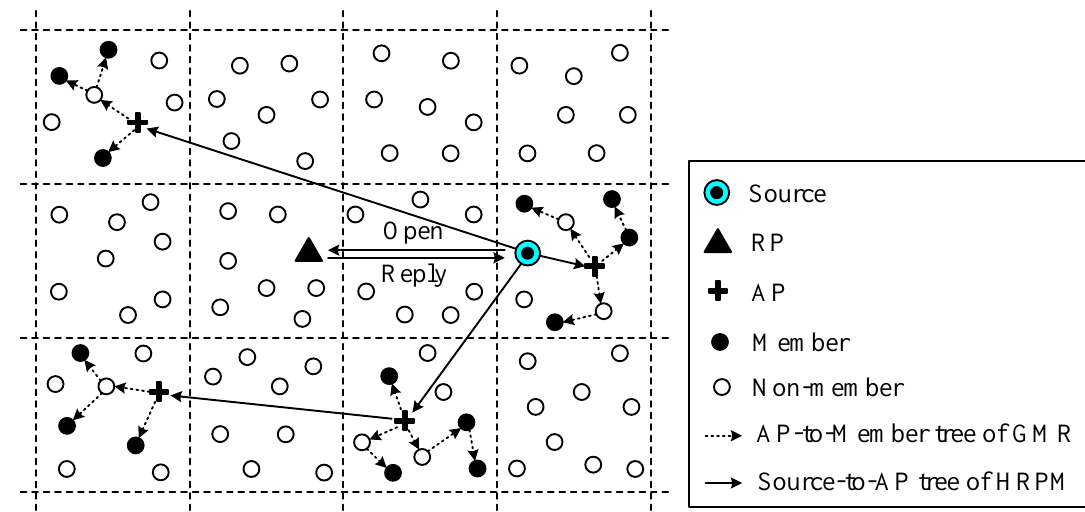
Figure 12. Illumination of data delivery in